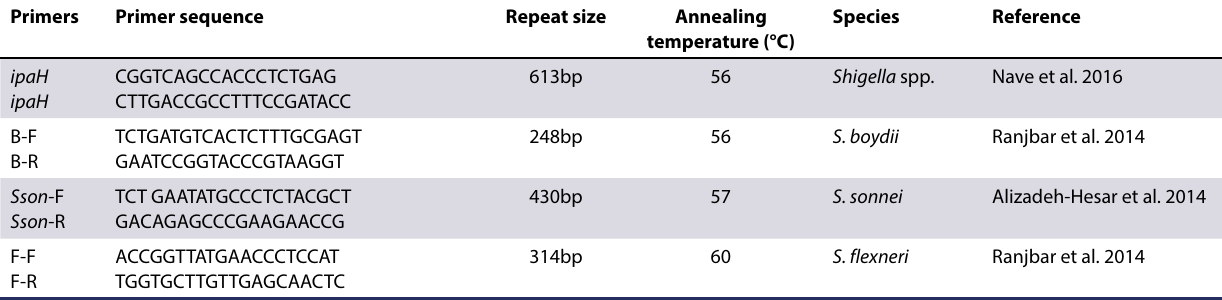
Table I: Sequences of primers, annealing temperatures and amplicon sizes for Shigella spp. Primers